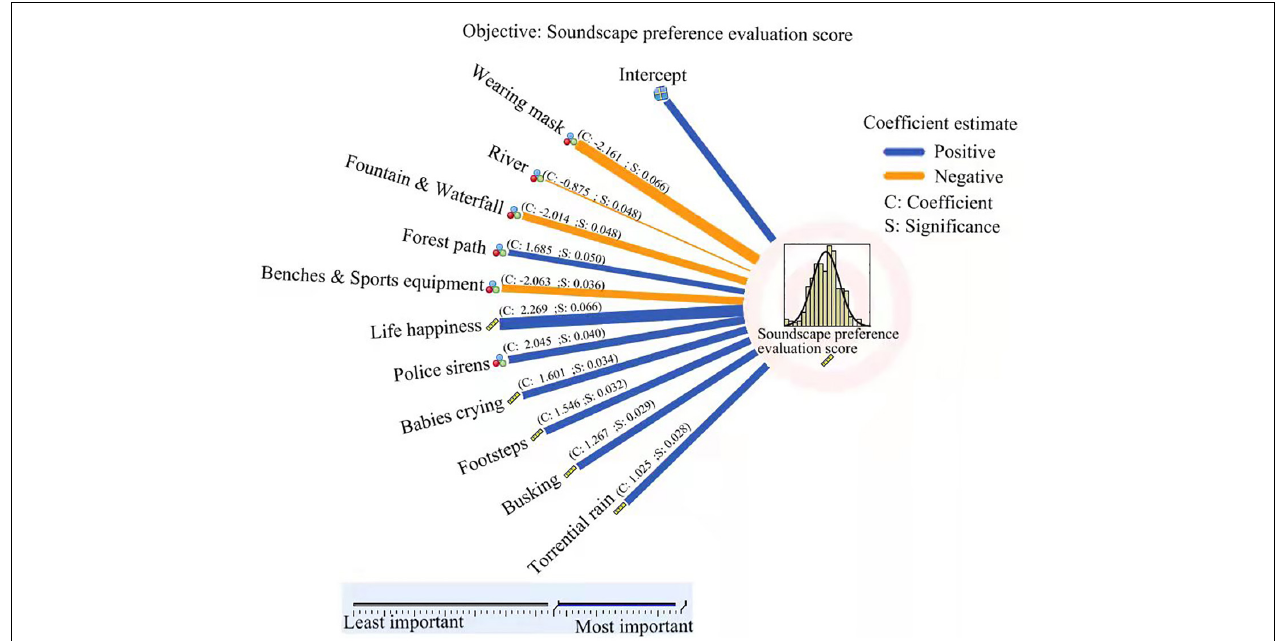
FIGURE 13 | Automatic linear model of soundscape preference evaluation score as